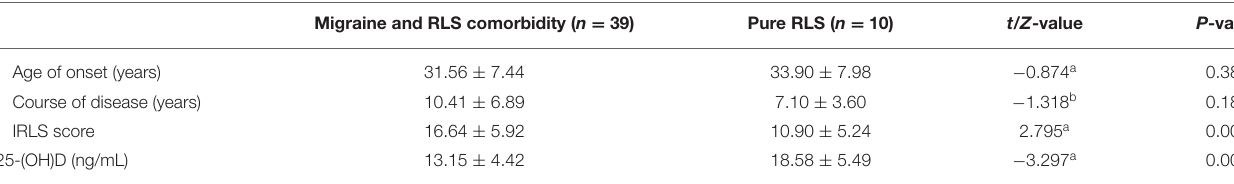
TABLE 2 | The IRLS score and vitamin D levels between migraine and RLS comorbidity group and pure RLS group. Migraine and RLS comorbidity ( n =